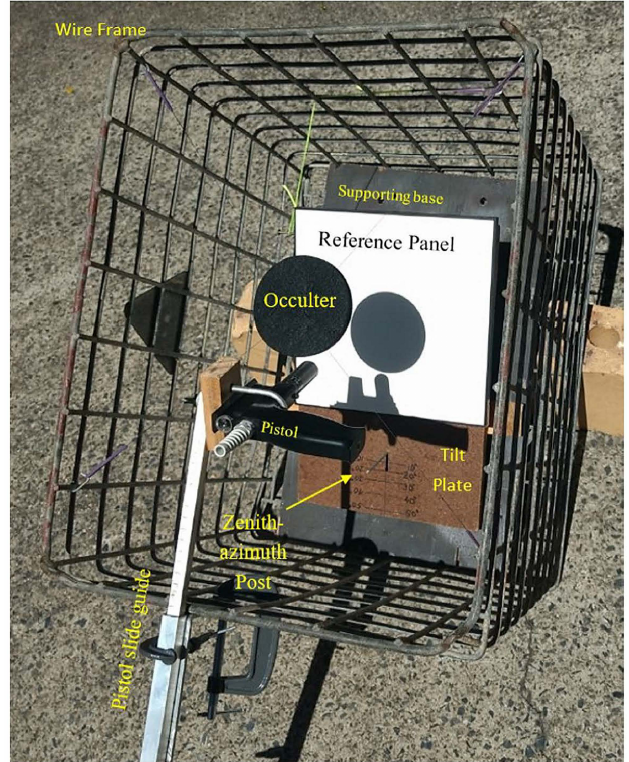
Figure 5. Field setup showing wire frame, black supporting base, brown tilt plate, reference panel, occulter, zenith / azimuth post set at 20 ◦ zenith, spectrometer pistol, and pistol guide slider to ensure accurate spacing of signature